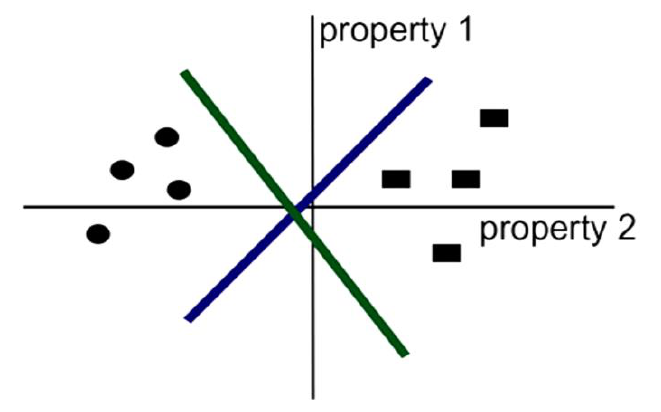
Figure 1. SVMs generated